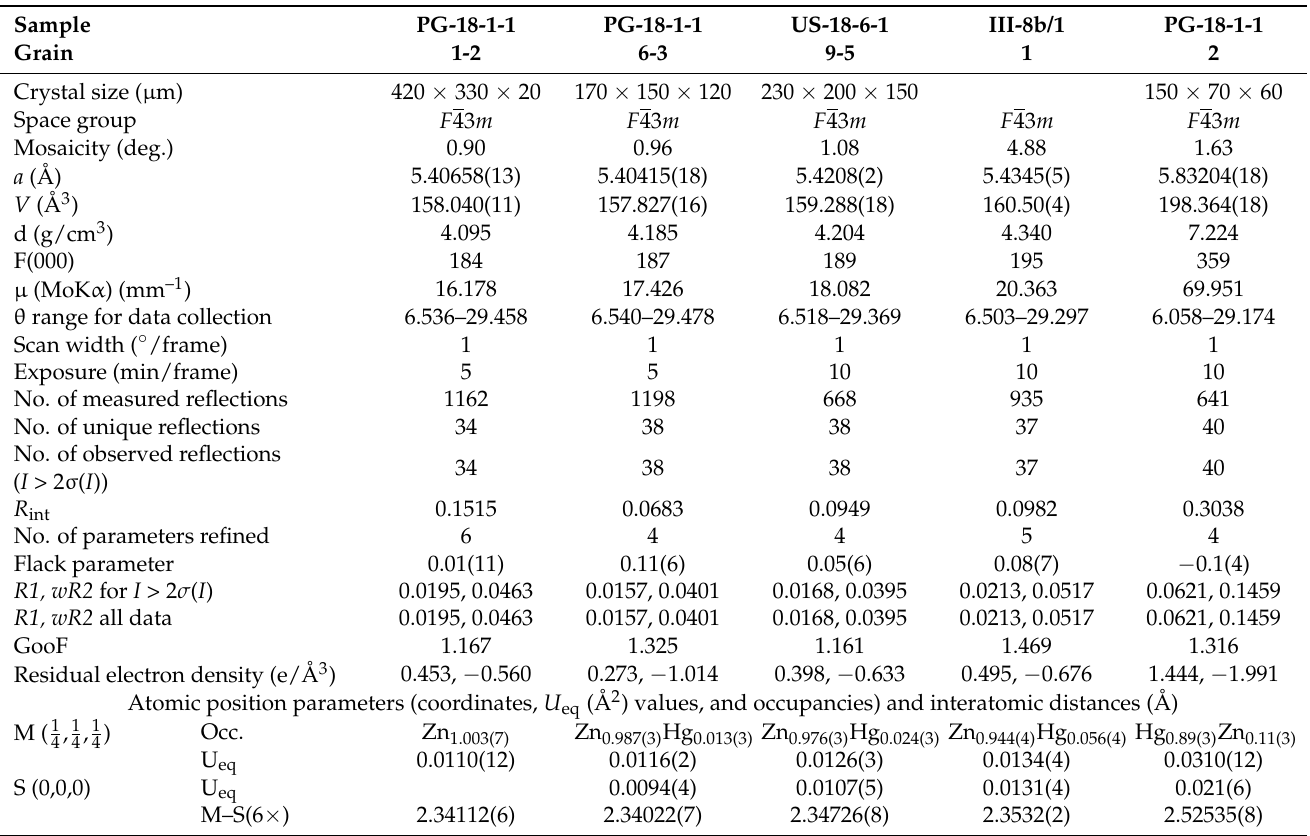
Table 10. Data collection and structure refinement details for (Zn,Hg)S.